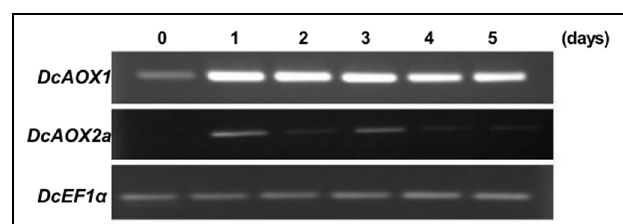
FIGURE 4 | Transcript level of DcAOX1 and DcAOX2a genes in leaves of Daucus carota cv Rotin seedlings exposed to chilling (4 ◦ C) for 5 days. EF1 α cDNA was used as reference gene and the gel profiles are representative of three independent RT reactions from three biological